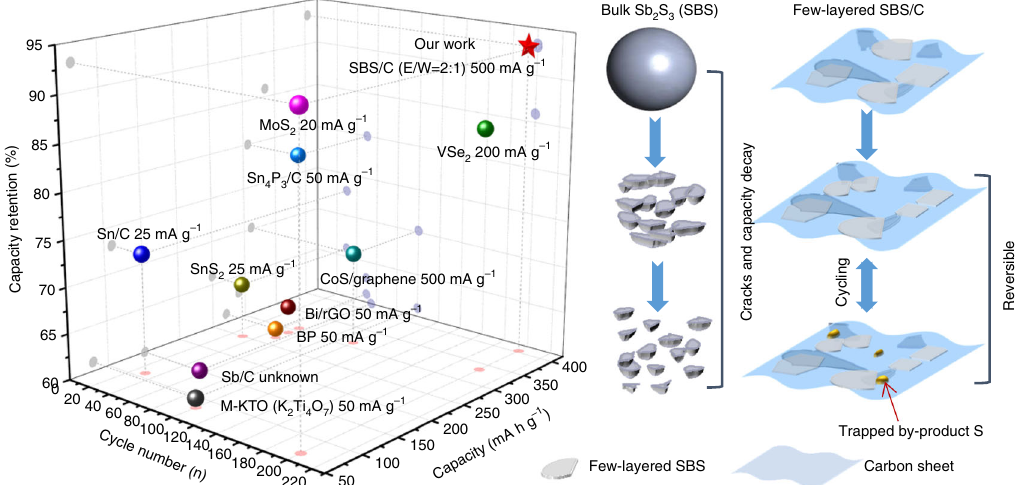
Fig. 5 State-of-the-art reported anodes (except for carbon/graphite) for KIBs 11, 34 – 42 , and schematic illustration of working mechanism of bulk SBS and few-layered